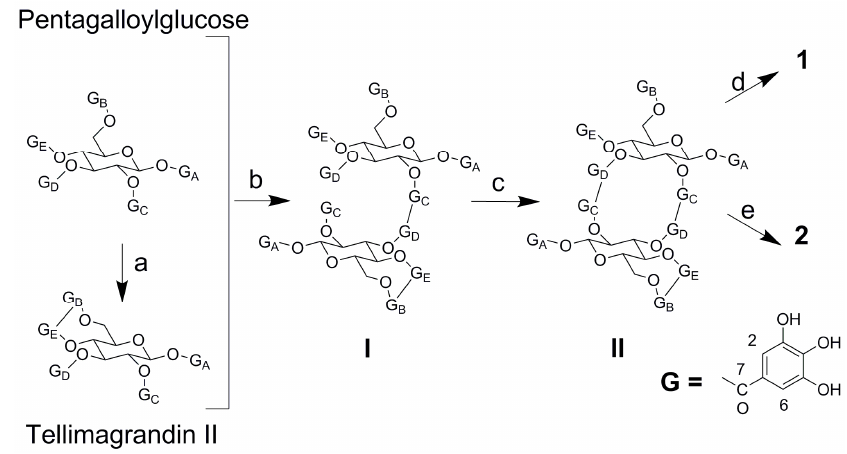
Figure 3. Biogenetic Approach to obtain merianin A ( 1 ) and merianin B ( 2 ), ( a ) Intramonomeric C–C oxidative coupling, ( b ) and ( c ) intermonomeric C–C oxidative coupling, ( d ) and ( e ) intramomomeric C–O–C oxidative coupling.